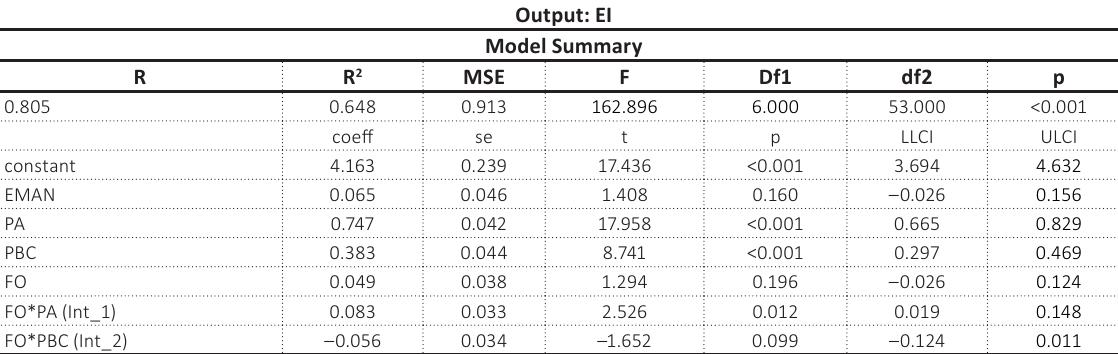
Table 5. Regression results for the moderation effects